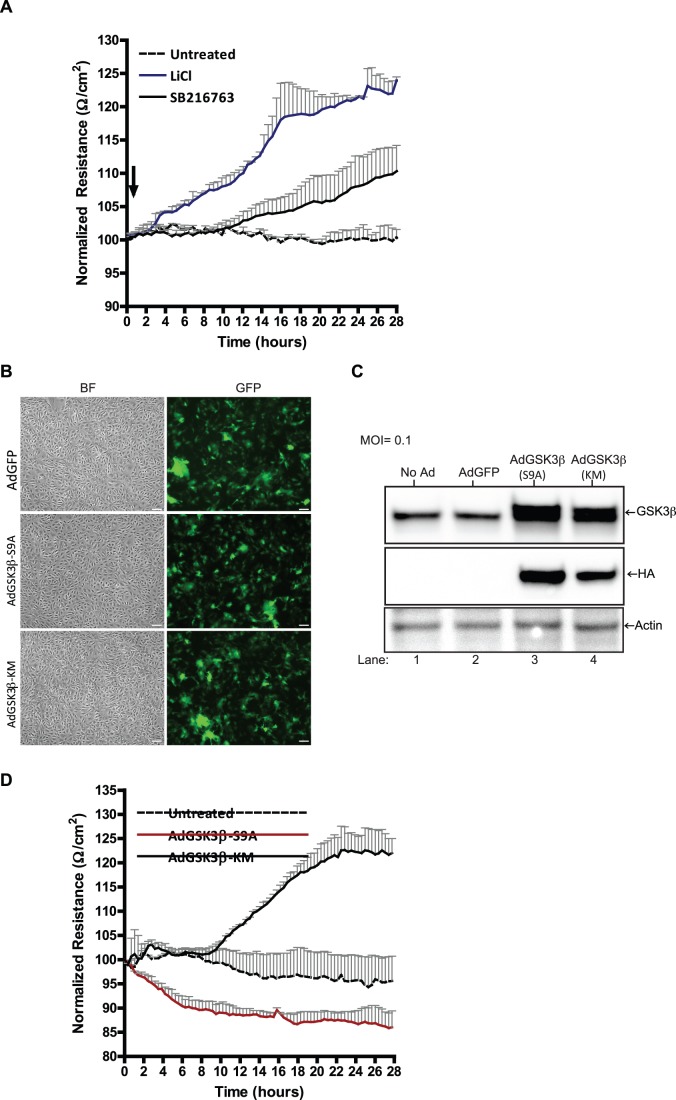
GSK3β inhibition affects barrier function.(A) Trans-Endothelial Electrical Resistance (TEER) was measured continuously in primary human brain microvascular endothelial cells (BMVEC) with or without GSK3β inhibitors LiCl (10 mM) and SB216763 (20 µM). After baseline TEER was achieved (between 7–10 days), the inhibitors were added at the time point indicated by the arrow. The resistance was measured at 4000 Hz in 20-min intervals for the duration of the time shown. (B) Representative images from BMVEC exposed to adenoviral vectors expressing the GSK3β mutants. The vectors are bicistronic for GFP which allows for monitoring of transduction efficiency which was greater than 80% (5X objective power magnification; scale bar:100 microns). (C) After 24 hr post-infection, transduced BMVEC were lysed and western blots examined for over-expression of mutant protein. Adenovirus-mediated gene transfer resulted in high expression of GSK3β mutants (lanes 3 and 4). The detection of human influenza hemagglutinin (HA) peptide tag fused to the GSK3β mutant denotes the specific expression level of the transgene. (D) TEER measurements (∼18 hr post infection) were performed on BMVEC transduced at a multiplicity of infection (MOI) of 0.1 with adenovirus-expressing mutants of GSK3β. AdGSK3β-KM indicates the dominant negative form of GSK3β containing a mutation in the kinase domain. AdGSK3β-S9A expresses the active form of GSK3β which prevents inactivation by phosphorylation on the serine 9 residue. TEER values are represented as the average (line) normalized TEER with the positive SEM (n = 3).